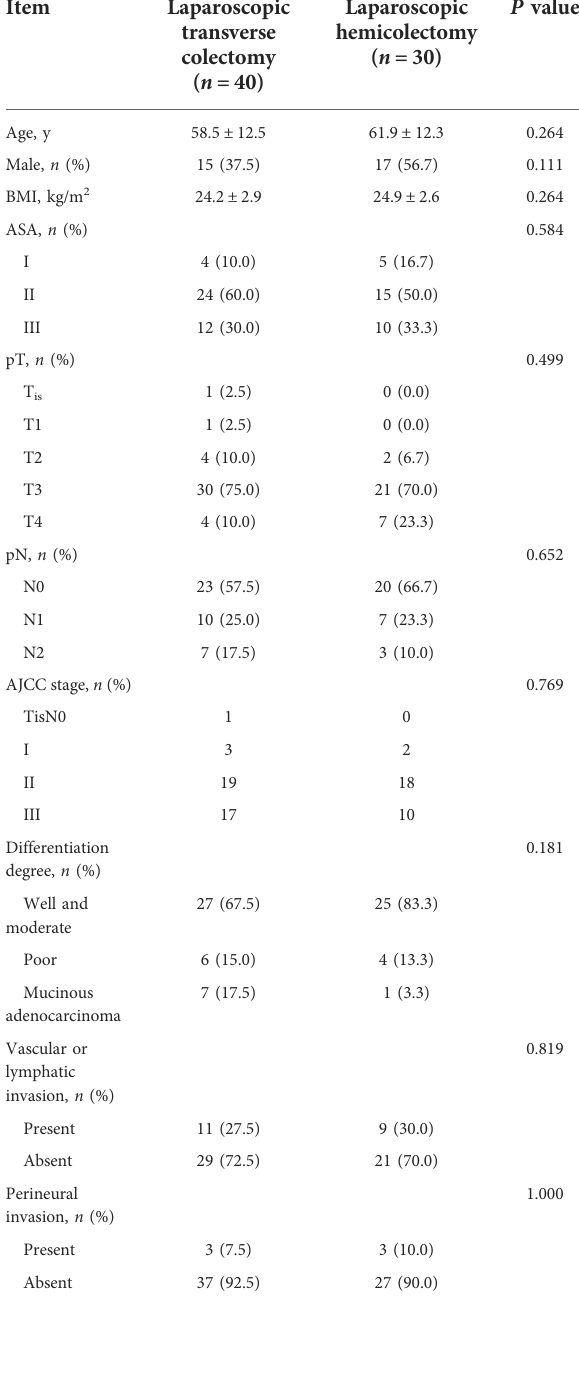
TABLE 1 Baseline